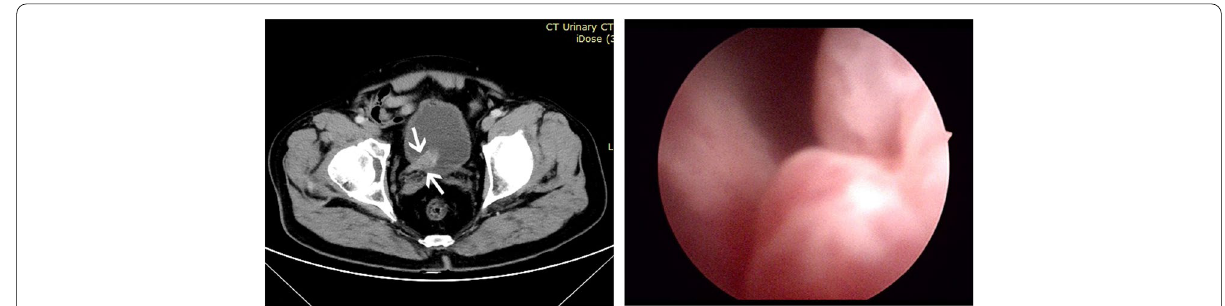
Fig. 1 Representative views of the ureteral tumor by computed tomography-urography (CTU) and cystoscopy. a CTU showed an enlarged soft tissue shadow along the pelvic segment of the right ureter and continuous bladder trigone. b Cystoscopic examination revealed an irregular, polypoid, and pedicled lesion in the ureteral